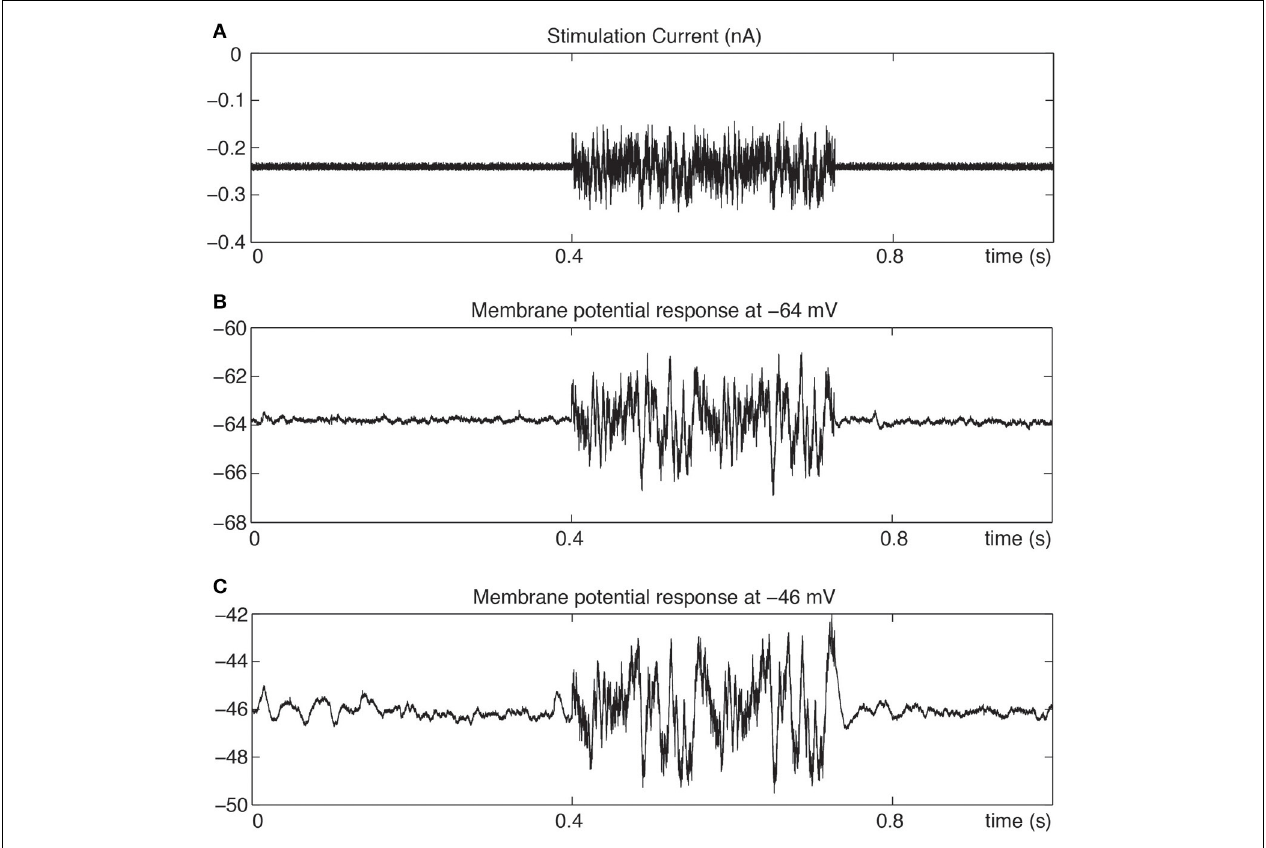
FIGURE 1 | Membrane potential response to multi-sinusoidal current stimulation with holding current adjusted to give − 64 and − 46mV average membrane potentials. (A) Stimulation current with range of